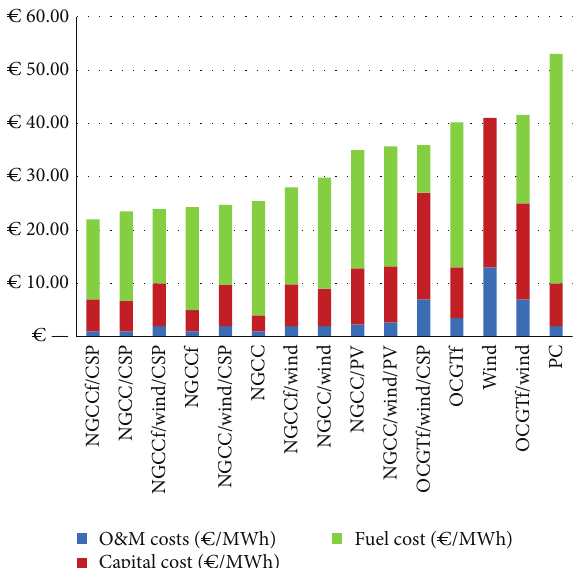
Figure 7: Energy combination profitability (at 20 years).